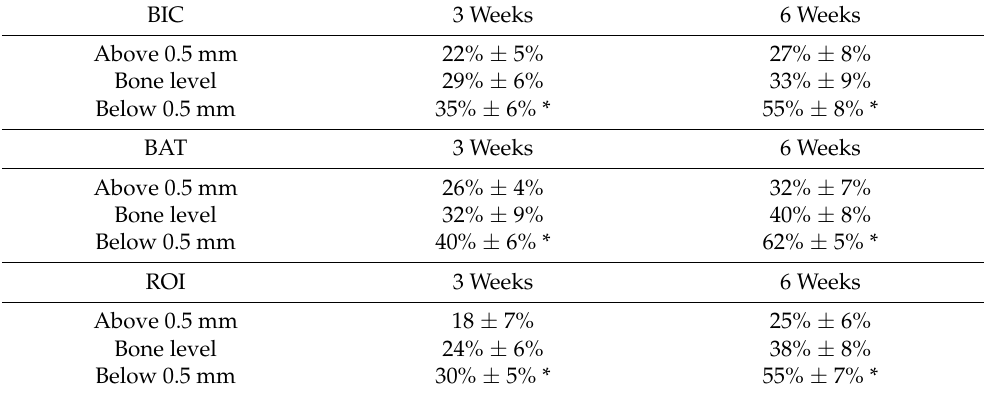
Figure 9. Histologies of the different bone-level dental implants inserted at 0.5 below the bone level (h = − 0.5 mm). ( A ) 3 weeks implanted and bone thickness of 1.5 mm; ( B ) 6 weeks implanted and bone thickness of 1.5 mm; ( C ) 3 weeks implanted and bone thickness of 2.5 mm; ( D ) 6 weeks implanted and bone thickness of 2.5 mm. Table 2. Bone index contact (BIC), total bone area (BAT) and region of interest bone growth (ROI) for different types of Ti dental implant surfaces after 3 or 6 weeks of implantation. Cortical thick- ness of 1.5 mm. Statistical differences for each column are indicated by single asterisk ( p < 0.05). Thickness: 1.5